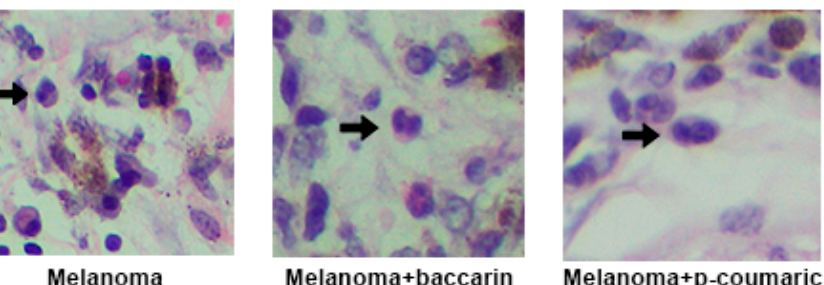
Figure 2. ( a ) Representative graphic of the mitosis analysis. Baccharin and p-coumaric acid reduced tumor mitotic activity. Comparison between the Control and Melanoma groups (B16F10 concentration of 10 6 cell/mL) that ingested only PBS and the baccharin and Melanoma + baccharin groups that received treatment with the baccharin compound (500 µ g/kg) for 26 days. Comparison with the Control and Melanoma groups (B16F10 concentration of 10 6 cell/mL) that ingested only PBS and the p-coumaric acid and Melanoma + p-coumaric acid groups that received the treatment with p-coumaric compound (500 µ g/kg) for 26 days. ( b ) Representative images of the mitosis in 200 × magnification. Data represents mean ± SEM. * These differences were considered significant with p < 0.05.